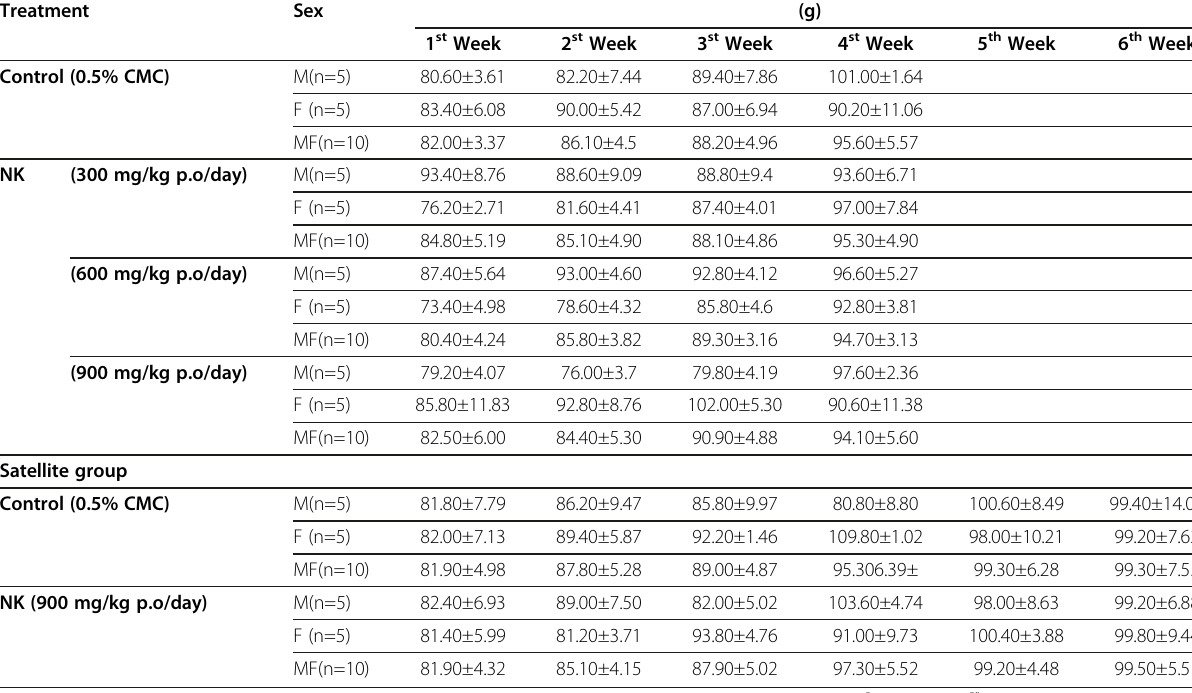
Table 5 Effect of Nuna kadugu on feed intake in experimental rats - repeated oral toxicity study